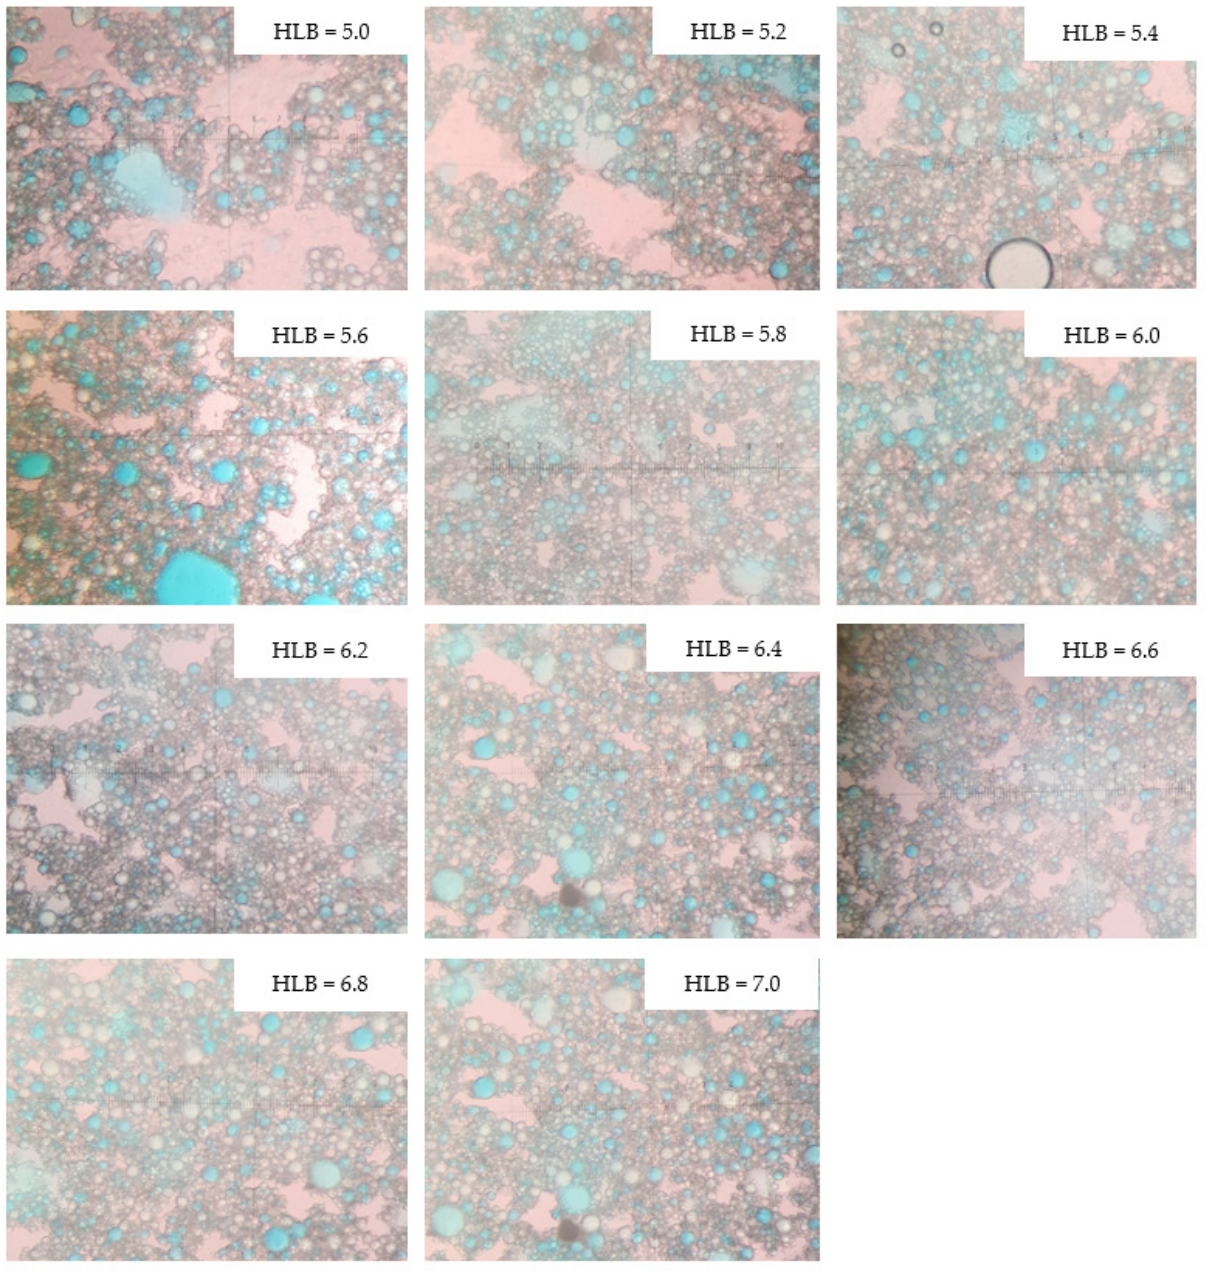
Figure 6. Optical microscopic image of emulsion droplet at different required HLB values ranging from 5.0–7.0 (40× magnification).